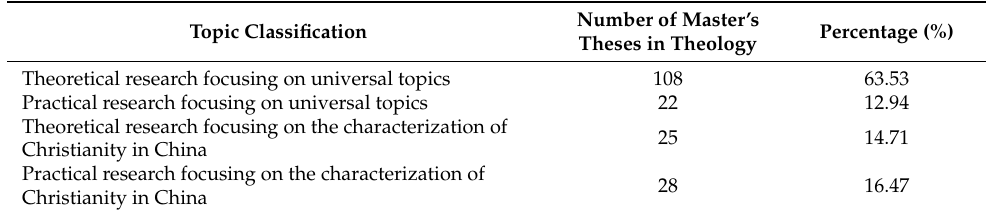
Table 2. Distribution of topics of master’s theses written by graduate students of China’s Christian